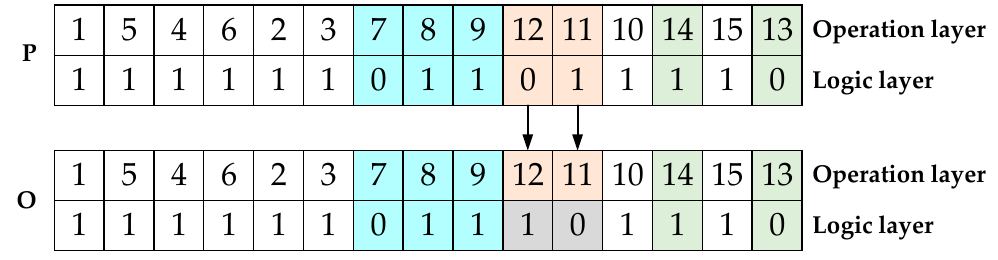
Figure 12. An example of mutation for logic layer.